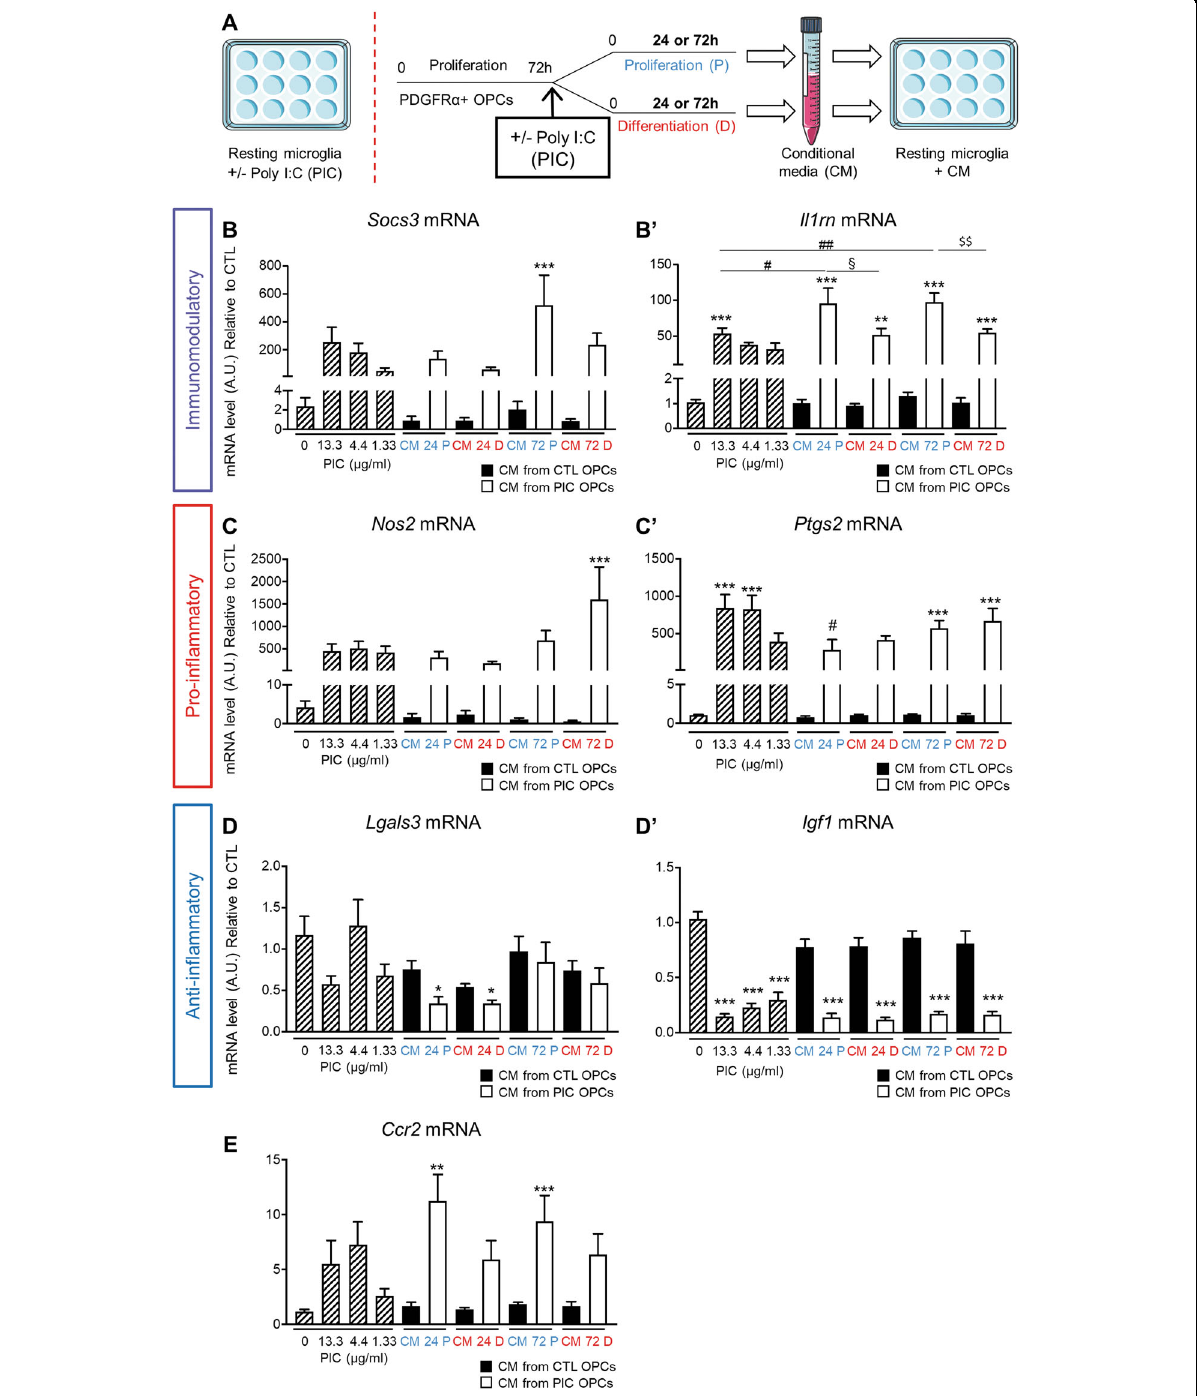
Fig. 7 Conditional medium (CM) from proliferating and differentiating OLs regulates microglia differently. A Experimental protocol. B – E qPCR analysis of microglia treated with PIC or conditional medium (CM). Results are the mean of three independent experiments performed in triplicate ±SEM, * P < 0.05, ** P < 0.01, and ***P < 0.001 vs CTRL, # P < 0.05 PIC 13.3 vs CM 24 P, ## P < 0.01 PIC 13.3 vs PIC CM 72 P, § P < 0.05 PIC CM 24 P vs PIC CM 24D, and $$ P < 0.01 PIC CM 72 P vs PIC CM 72D, One-way Anova followed by Bonferroni ’ s multiple comparison test was